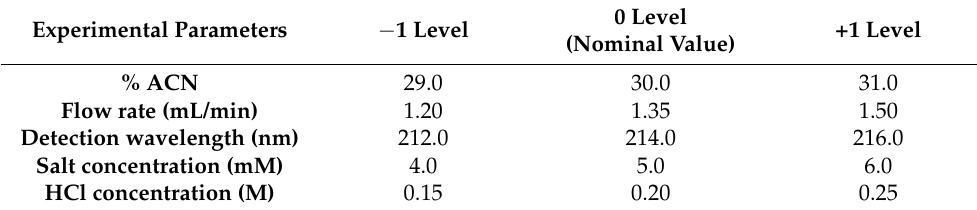
Table 2. Experimental factors and their examined levels.